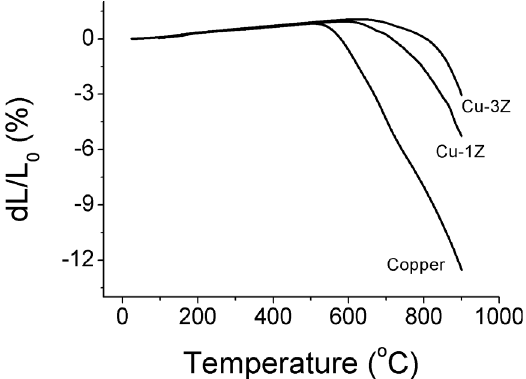
composites Figure 6. Dynamic sintering curves of Cu and Cu-ZrO 2 at 900 ºC in Ar/5%H atmosphere. 2 which it can be seen that in the case of Cu samples the total shrinkage registered was about 12% and that sintering starts from 500ºC; this is an expected temperature for sintering of copper powders 34 The highest densification rate is achieved . at 690ºC. After this temperature, the densification rate starts of the sintering event. From 760ºC the increased sintering rate can be associated with the creep action produced by